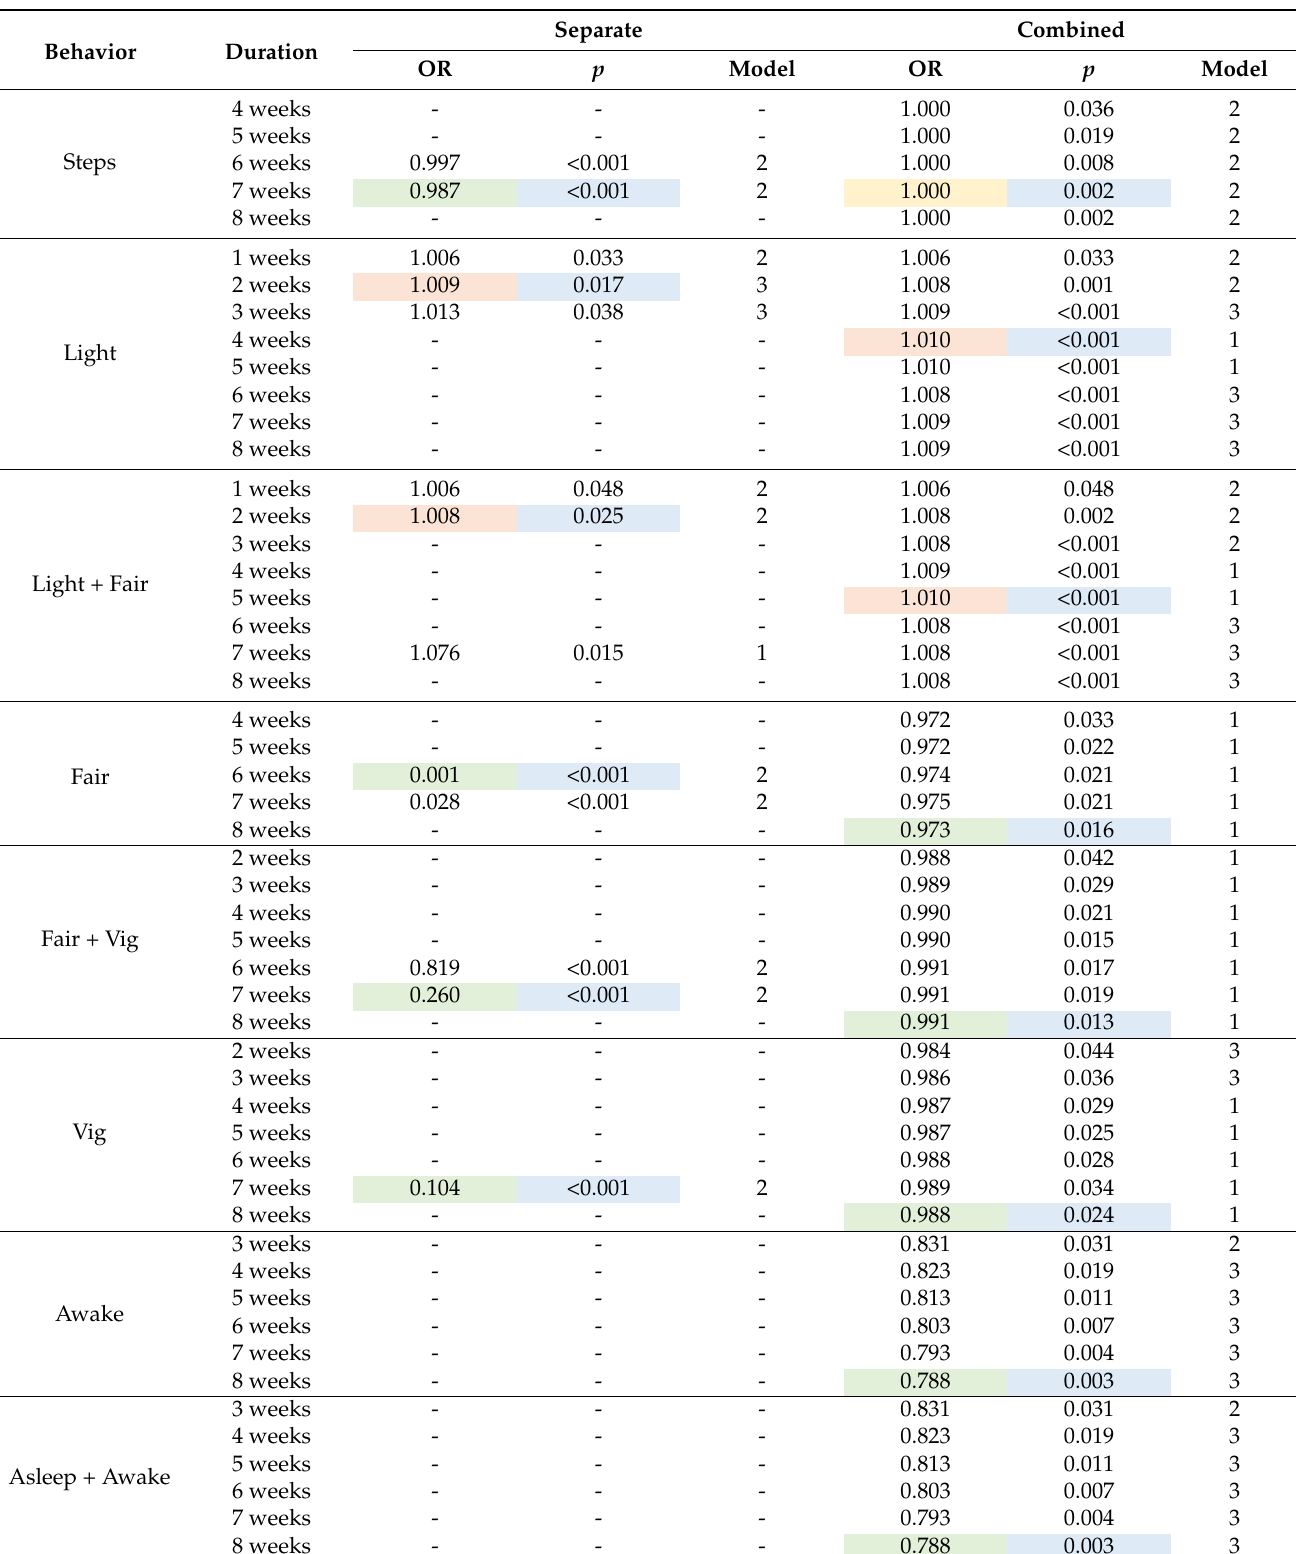
Table A13. Results by period duration across all conditional logistic regression models in validation scenario type